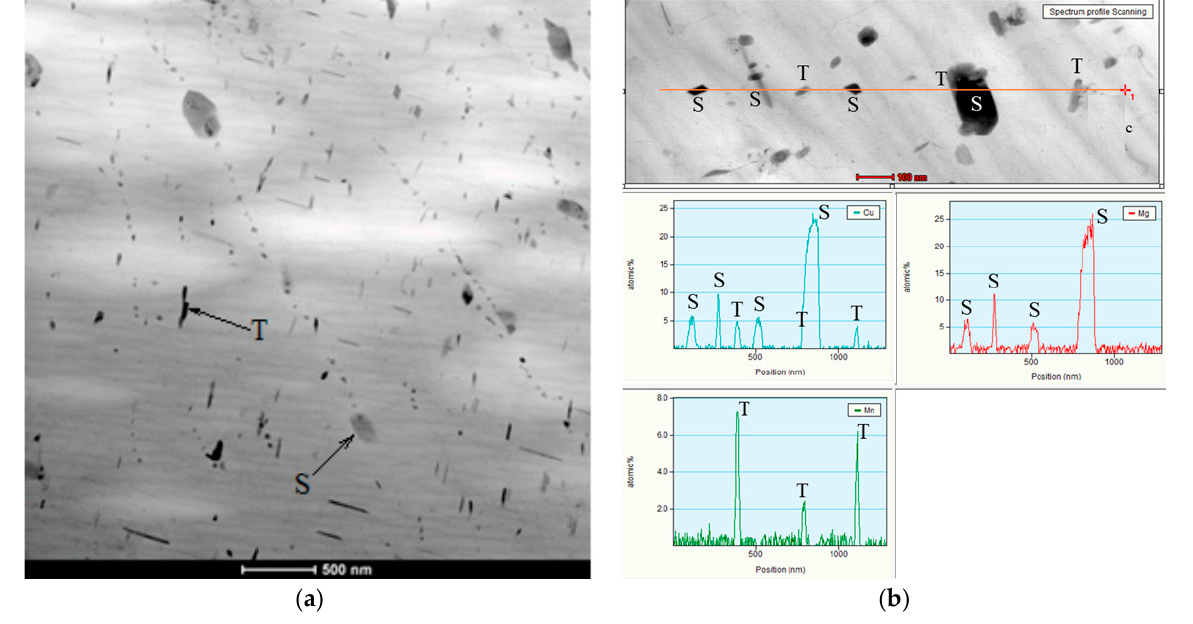
Figure 11. Transmission electronic microscopy of the 5Mg0.5Mn0.5Cu alloy ( a ). EDS results for the 5Mg0.5Mn0.5Cu alloy ( b ).